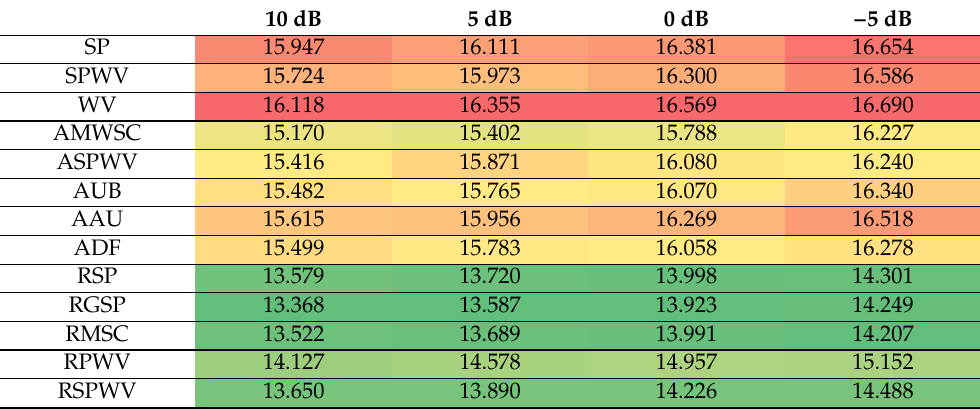
Table 4. TFR Rényi entropy for a noisy mono-component sinusoidal FM signal for different SNR levels (averaged over 100 noise realizations), cell colors range from green for the best result to red for the worst result in each column